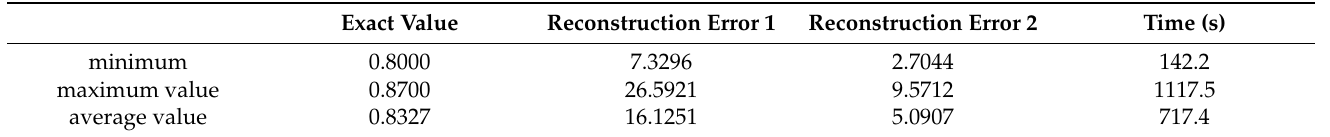
Table 5. DBN: X600-300 statistical